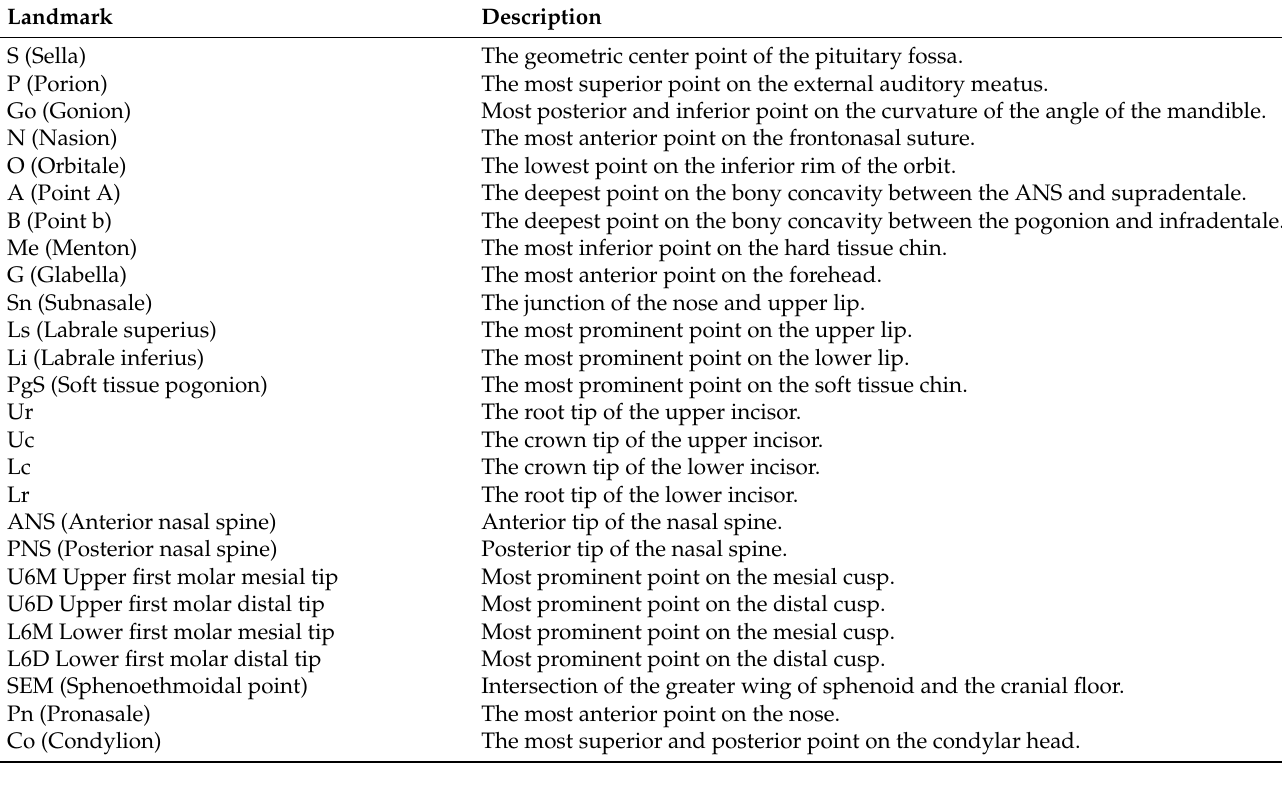
Table 1. Description of the landmarks used in the study.